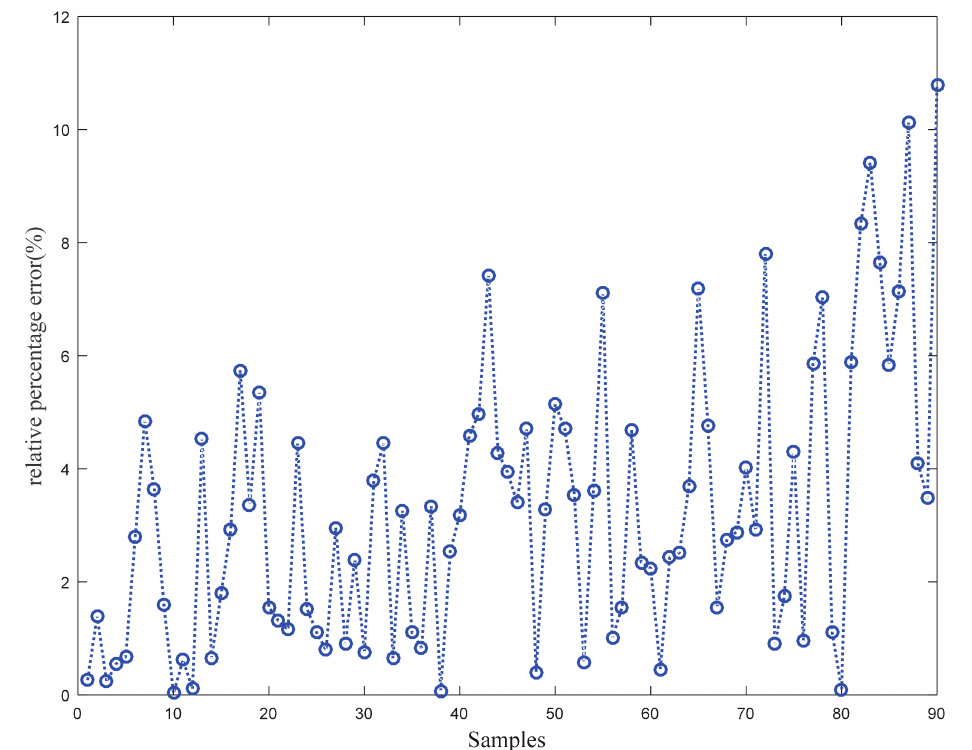
Figure 5. Relative percentage error of ethylene gas concentration prediction